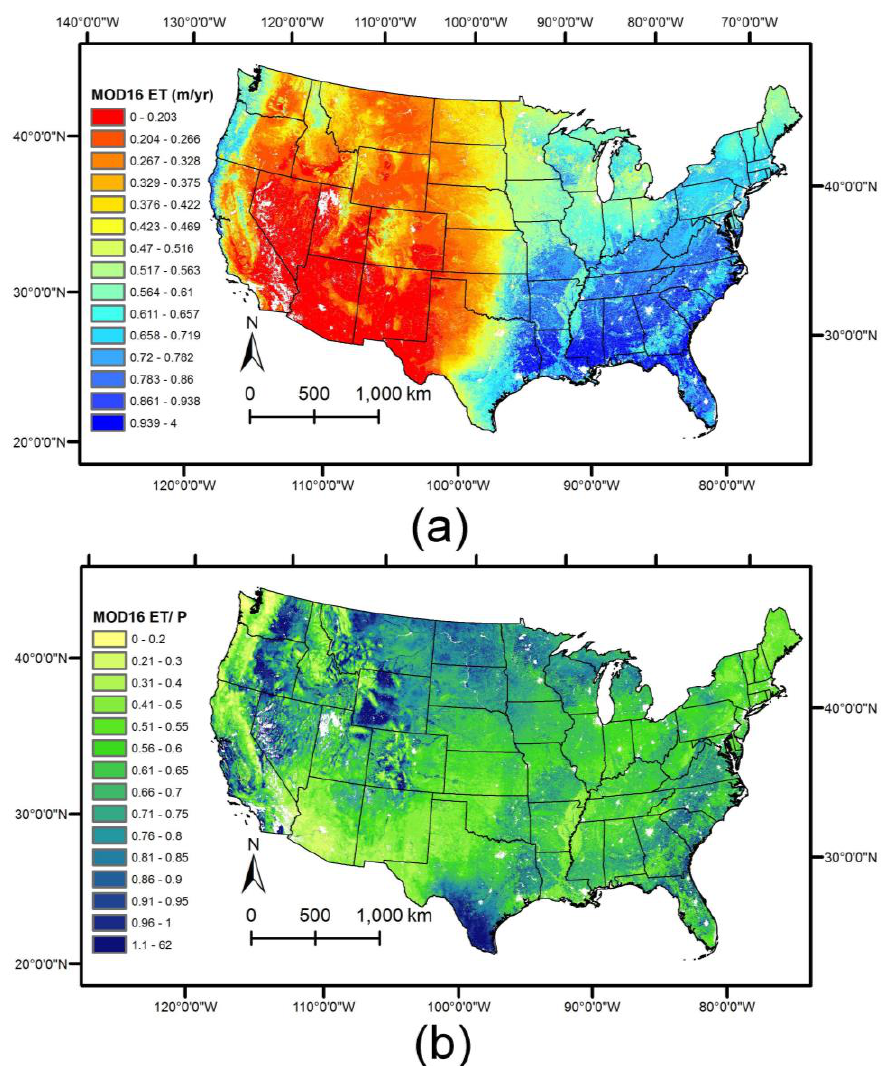
Figure 4. MOD16 ET data. ( a ) Average annual ET for the 2000–2013 timespan as estimated using the MOD16 model; ( b ) ET/ P for the MOD16 ET. Clear areas (no data) represent urban areas or water bodies, which are not included in MOD16 data sets.